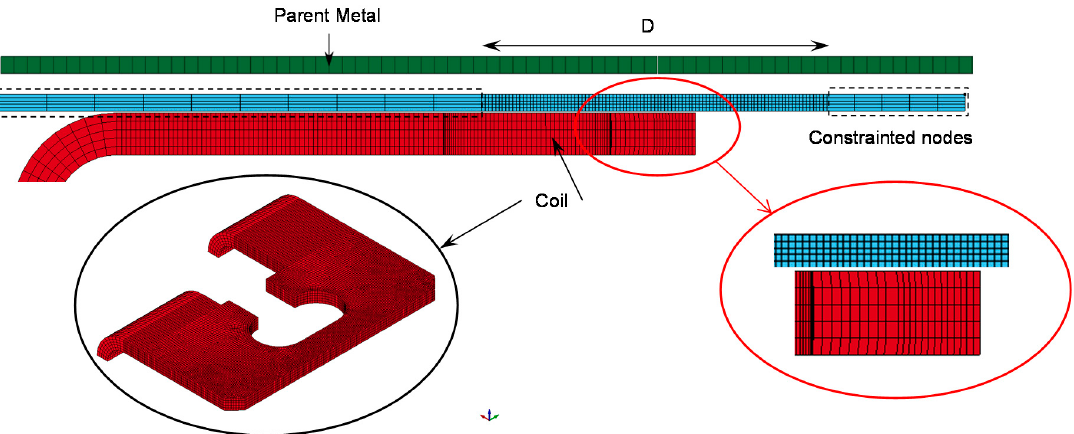
Figure 10. Problem with (R, L, C) imposed voltage on the coil [28]